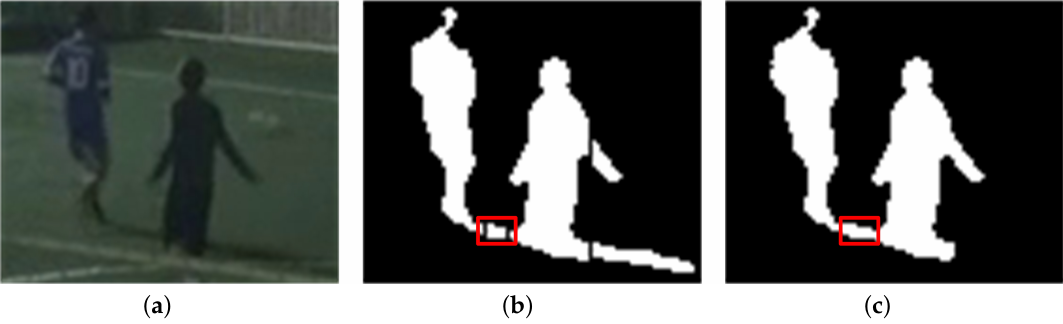
Figure 15. Shadow removal result 4 for multiple foreground objects (140 × 105 pixels from sequence